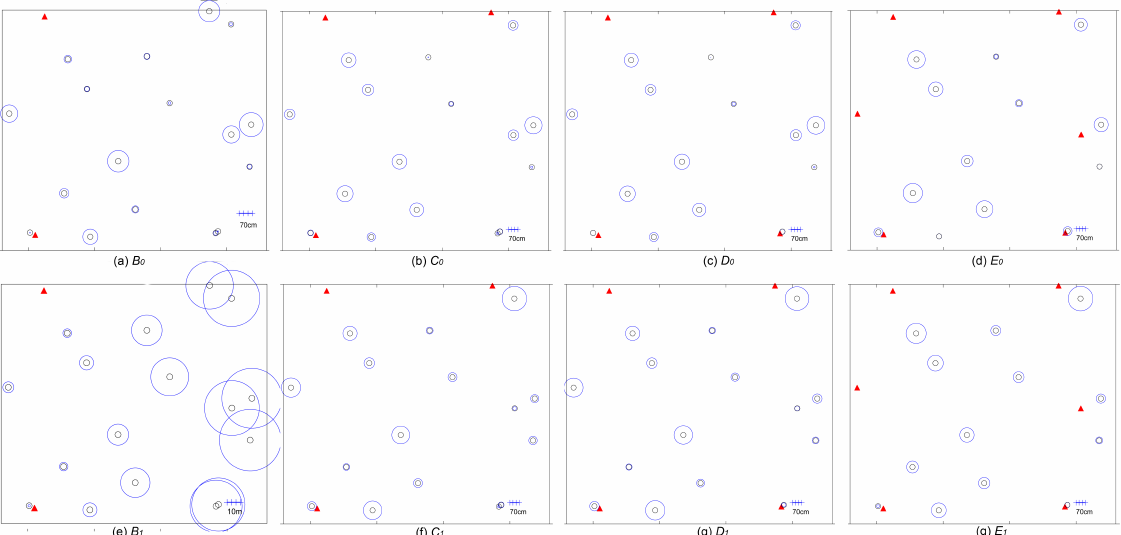
Figure 6: Oregon; BA results in different test scenarios. Red triangular markers correspond with the GCPs, the black circular markers are the CPs, and the blue circle radius’ indicate the discrepancies between the BA-estimated and true values of LiDAR-derived control points. Note the different scales in (a) and (e).